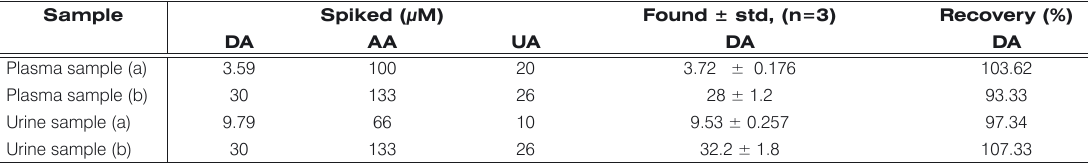
Table 4. Results of analysis of DA in human plasma and urine samples. Sample